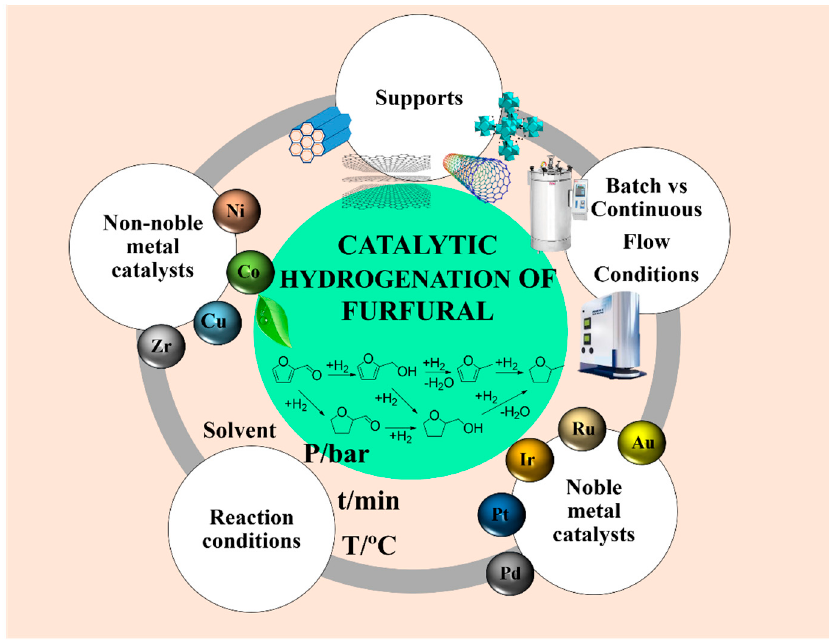
Figure 7. Representation of general factors that influence catalytic hydrogenation of furfural.